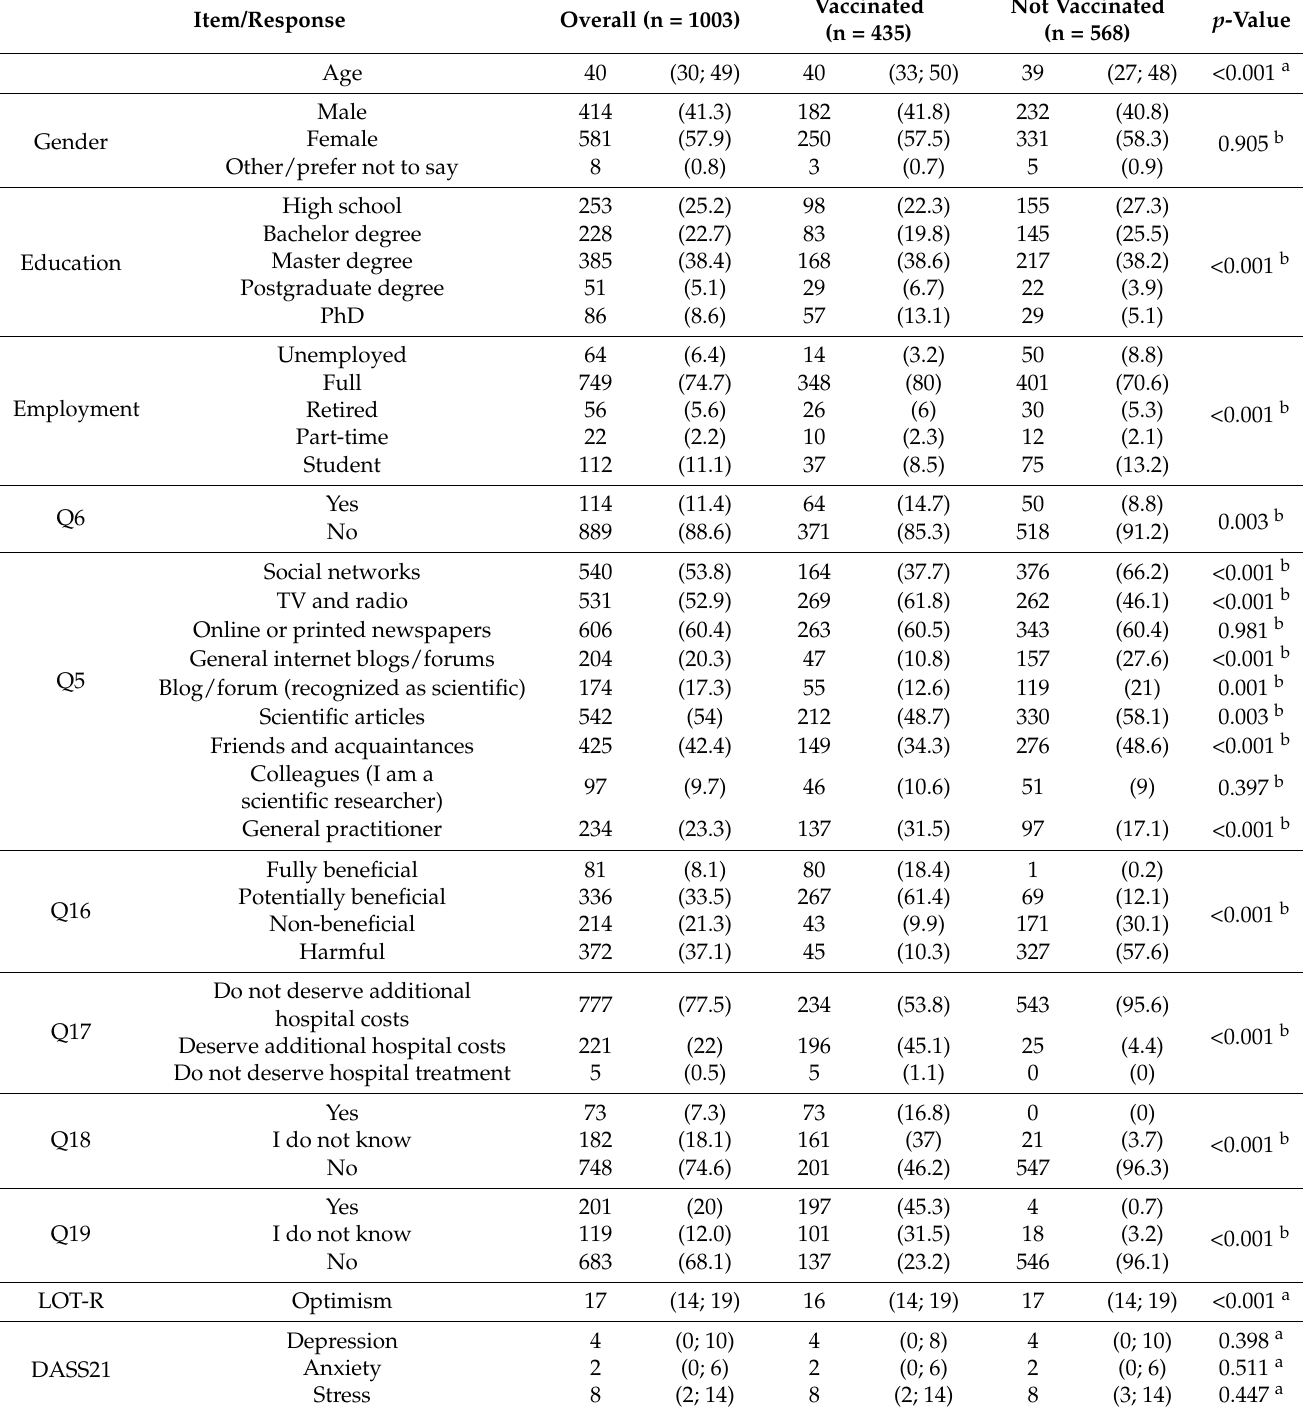
Table 1. Sociodemographic/SARS-CoV-2 and related COVID-19 diseases questions, attitudes towards COVID-19 passes, and